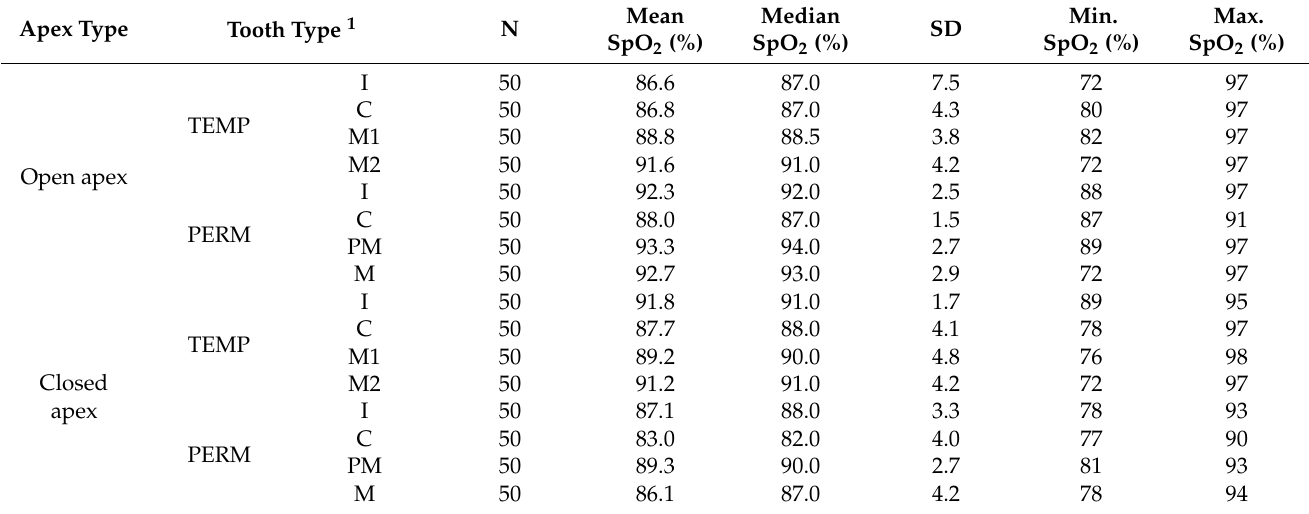
Table 1. SpO 2 values of primary and permanent teeth by tooth type.